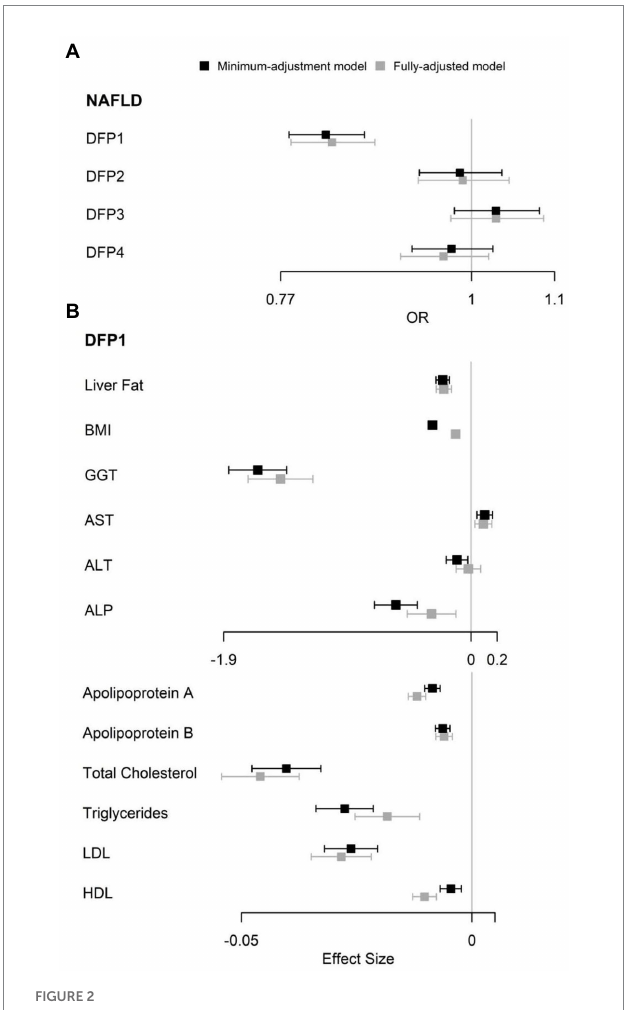
FIGURE 2 Observational association between DFPs with NAFLD and NAFLD related traits. (A) Observational association between DFPs with NAFLD. (B) Observational association between DFP1 with NAFLD related traits. OR, odds